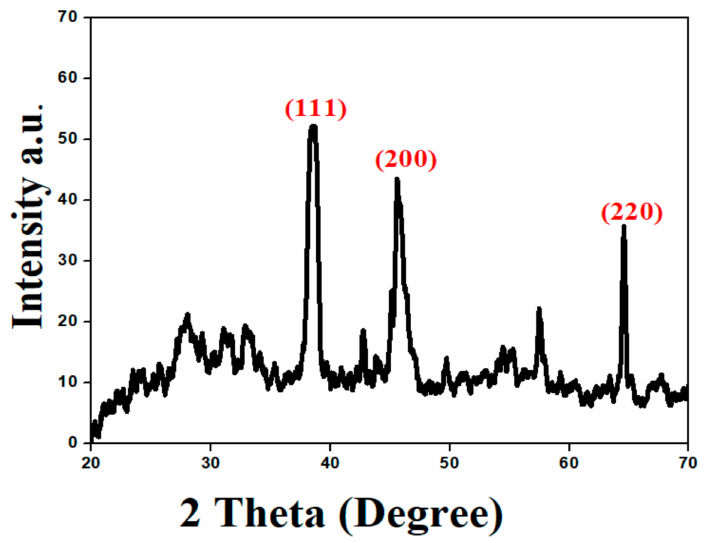
Figure 8. X-ray diffraction pattern of AgNPs synthesized from S. procumbens .